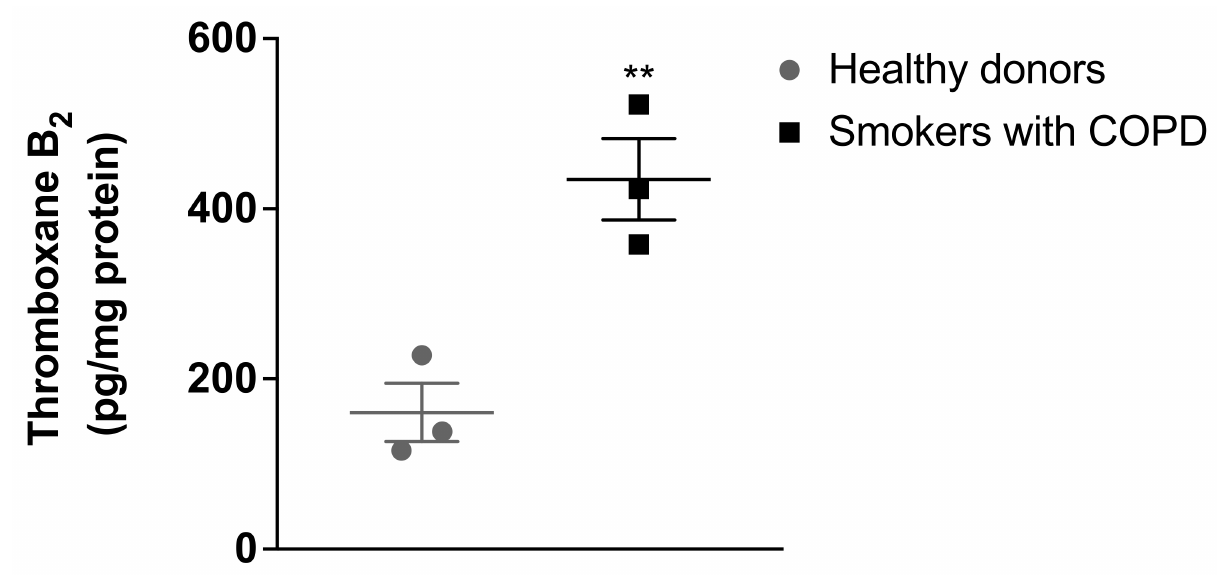
Figure 1. Levels of thromboxane B 2 in pulmonary artery smooth muscle cells from COPD patients who smoke. Confluent human pulmonary artery smooth muscle cells from healthy donors and patients with COPD with a history of smoking were placed in a cell culture medium for 72 h. The medium was collected and the levels of thromboxane B 2 were determined by ELISA. The results were normalised with total cell protein and expressed in pg/mg protein. Each data point represents the mean ± SEM using pulmonary artery smooth muscle cells from three healthy donors or smokers with COPD. ** p < 0.01 compared with pulmonary artery smooth muscle cells isolated from healthy